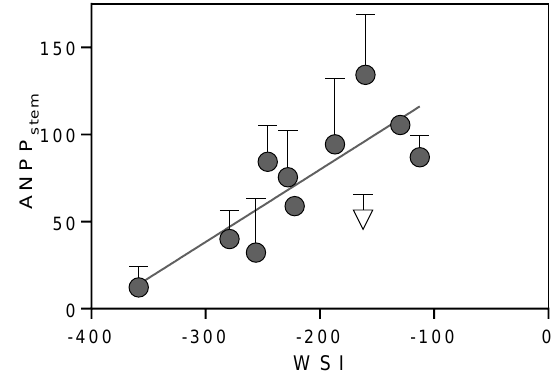
Figure 3. Ordinary least-square regression lines between the WSI and gross primary production GPP (light grey circle) and NEP (dark grey circle). WSI is expressed in MPa day, and both GPP and NEP are expressed in gCm − 2 yr − 1 . Data from 2005 that were not used in the analysis were also plotted (empty square for GPP and empty triangle for NEP).